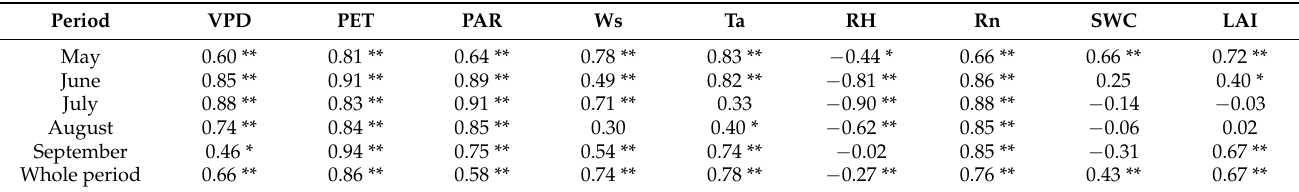
Table 3. Correlation coefficients between environmental factors and canopy